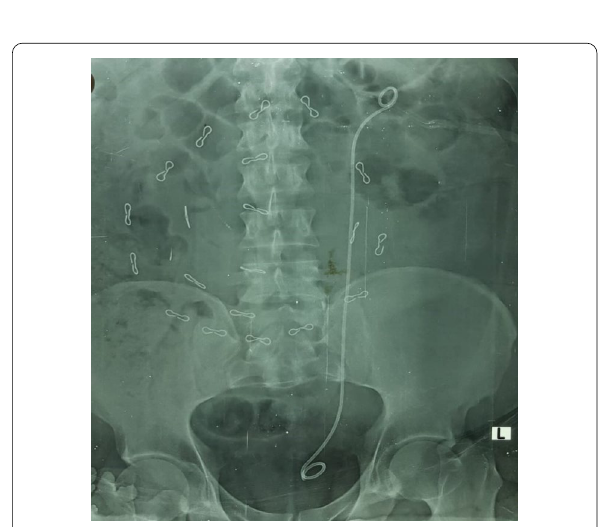
Fig. 4 The final plain X-ray demonstrated new left double